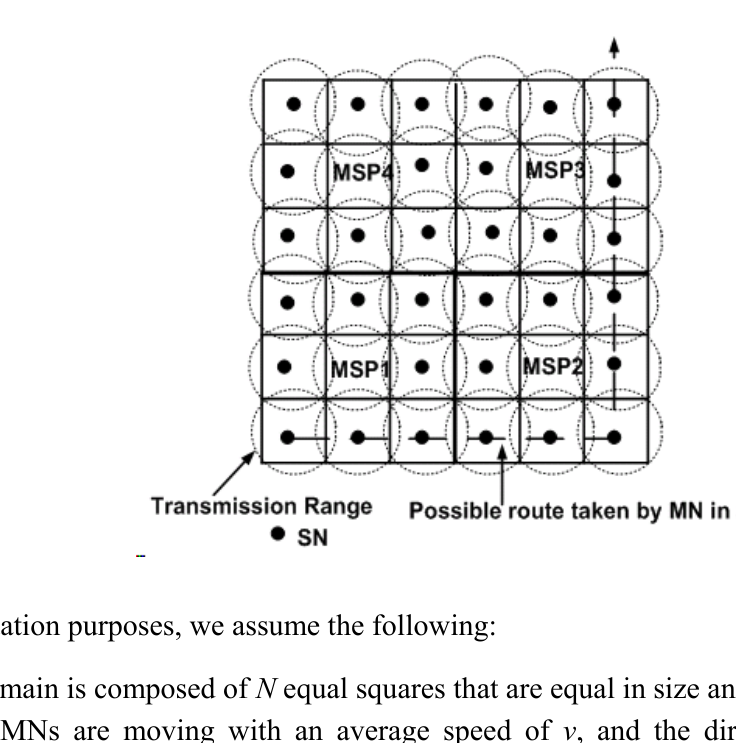
Figure 22. Association Region of SNs in the network